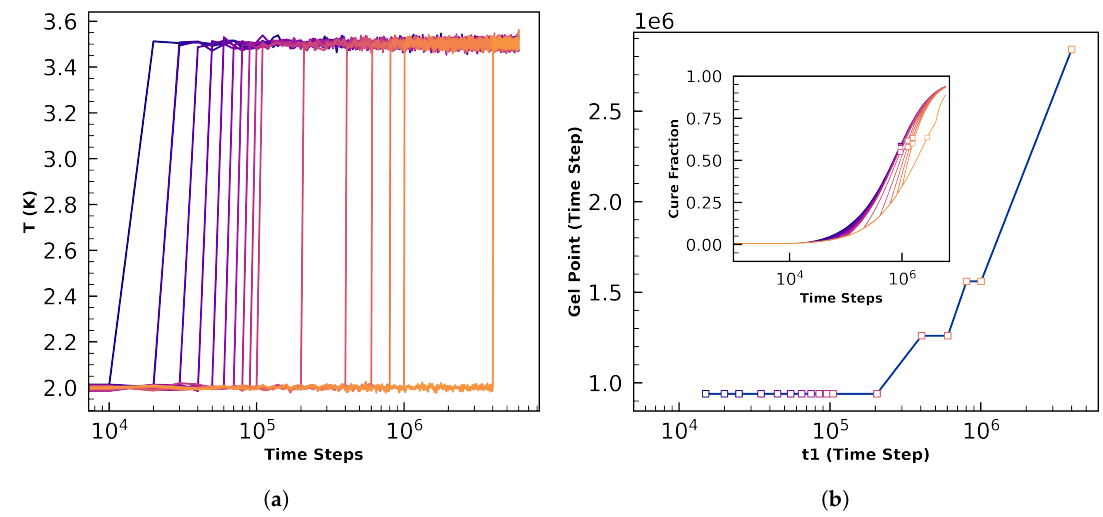
Figure 9. ( a ) Temperature profiles where the initial ramp up time ( t 1 ) is varied. ( b ) Time to gelation is not affected by t 1 < 2 × 10 5 ∆ t . t 1 time denotes the time at which the cure temperature is ramped up and held constant. Inset in ( b ) are the cure profiles on semilog axes with open squares indicating gelation times.